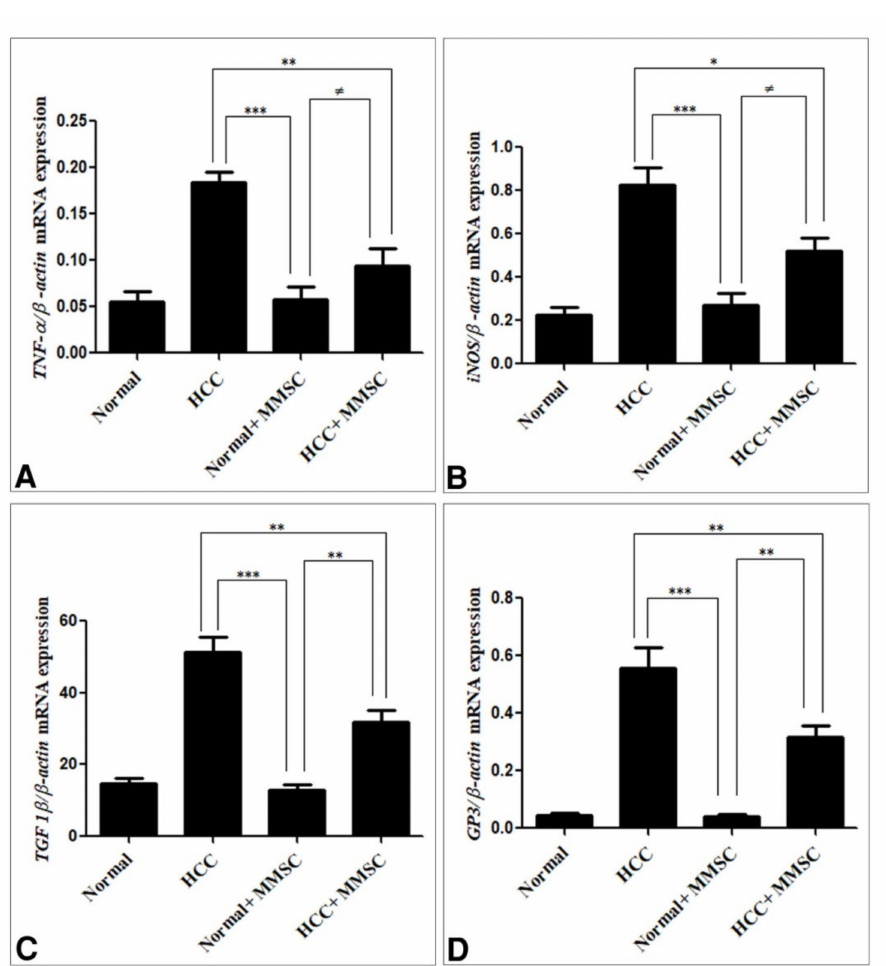
Figure 5. mRNA expression of genes ( A ) TNF- α , ( B ) iNOS, ( C ) TGF- β 1, and ( D ) GP3 in liver tissues. The mRNA expression levels were measured by qRT-PCR and normalized to β -actin binding protein. The following primer sets were used for the detection (Table 1). Data are the mean ± SEM. * Significantly different at p < 0.05 using ANOVA followed by Bonferroni’s as a post-hoc test, ** Significantly different at p < 0.001, *** Significantly different at p < 0.0001, (cid:54) = no significantly difference using ANOVA followed by Bonferroni’s as a post-hoc test. Hepatocellular carcinoma (HCC), S-methylmethionine sulfonium chloride